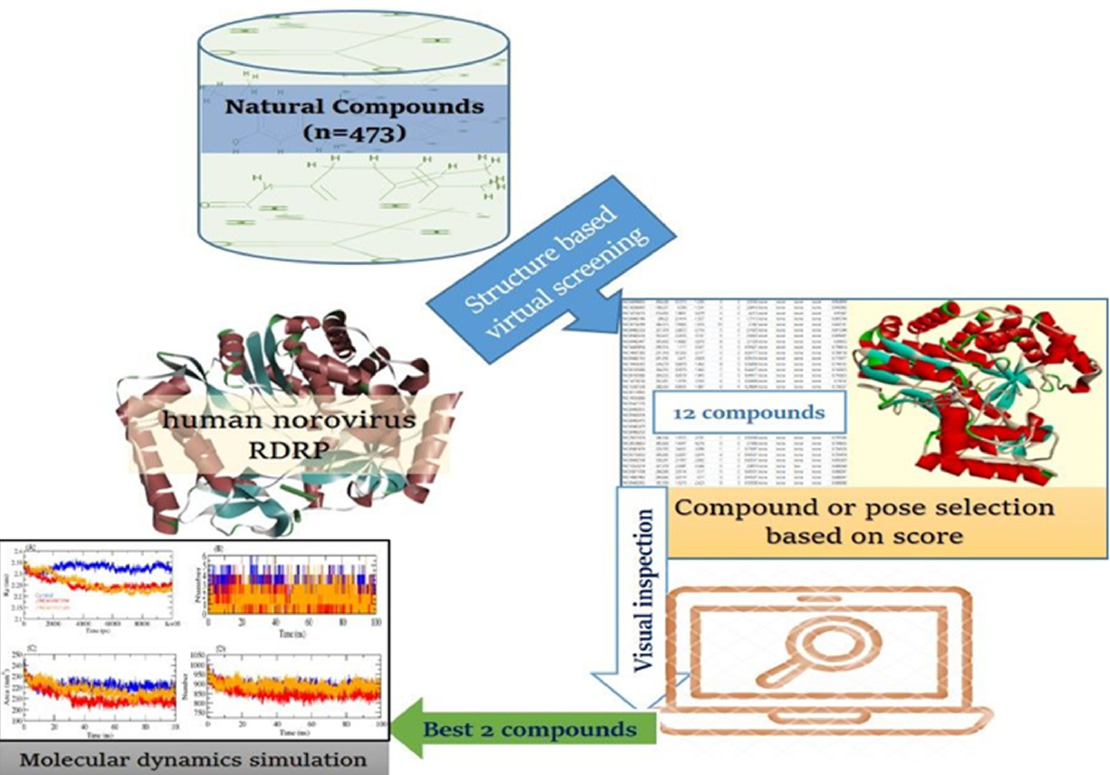
Figure 1. Flow diagram of study design.